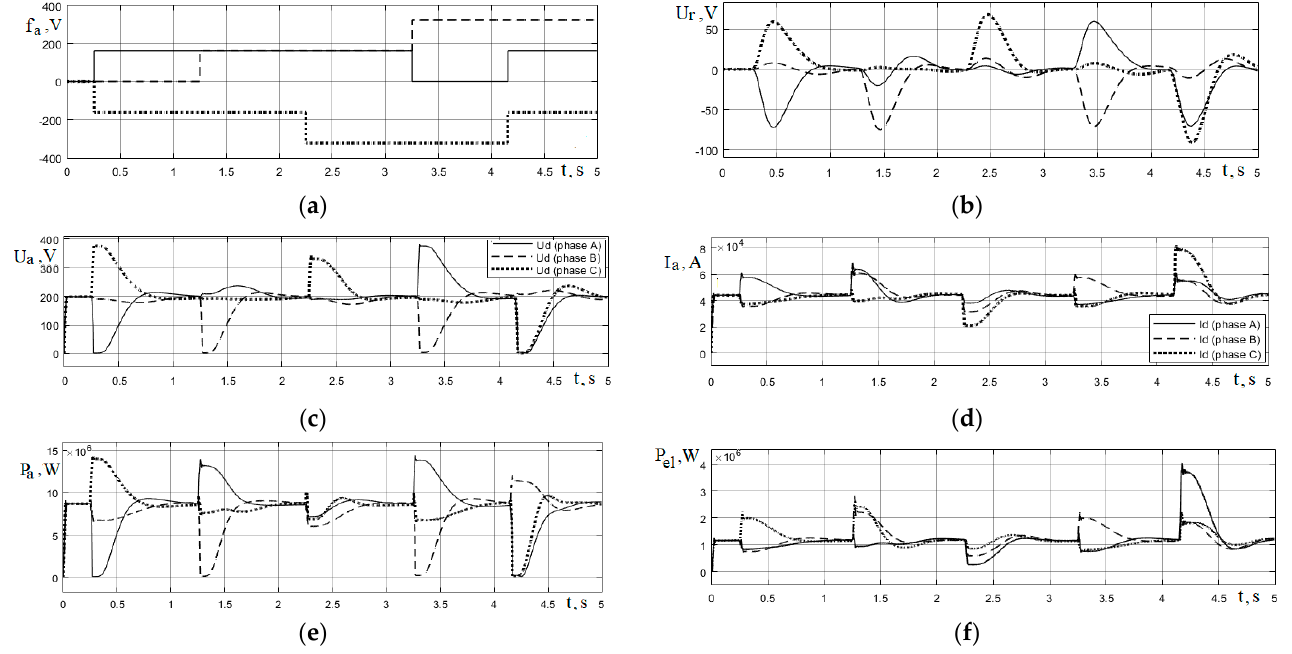
Figure 7. Time dependences of deterministic perturbations: ( a ) mismatch signals; ( b , c ) voltages; ( d ) currents; ( e ) power of arcs; ( f ) power of electric losses when using differential model (1) (ARDM-T-12).